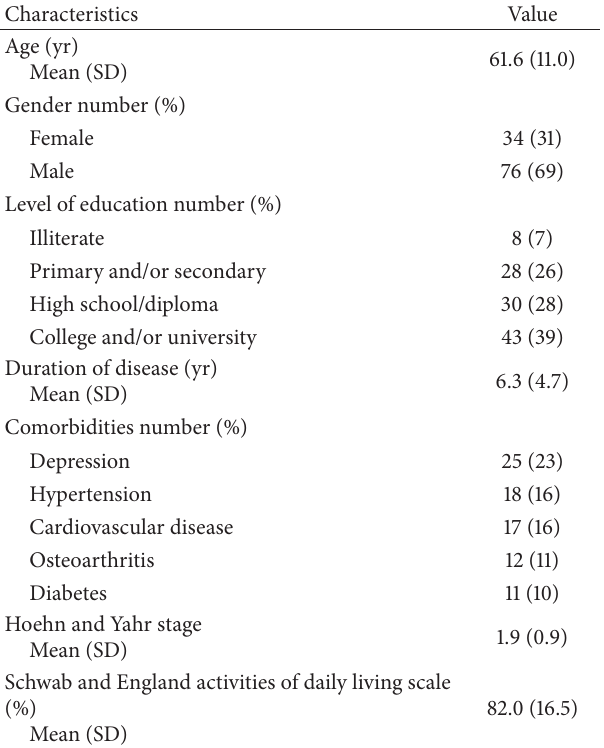
Table 1: Sociodemographic characteristics of Parkinson’s disease patients (𝑛 = 110)